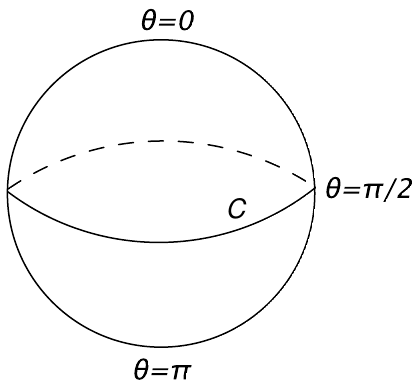
Figure 2 . Northern and southern hemispheres for (cid:12)xed r and , and the equator C